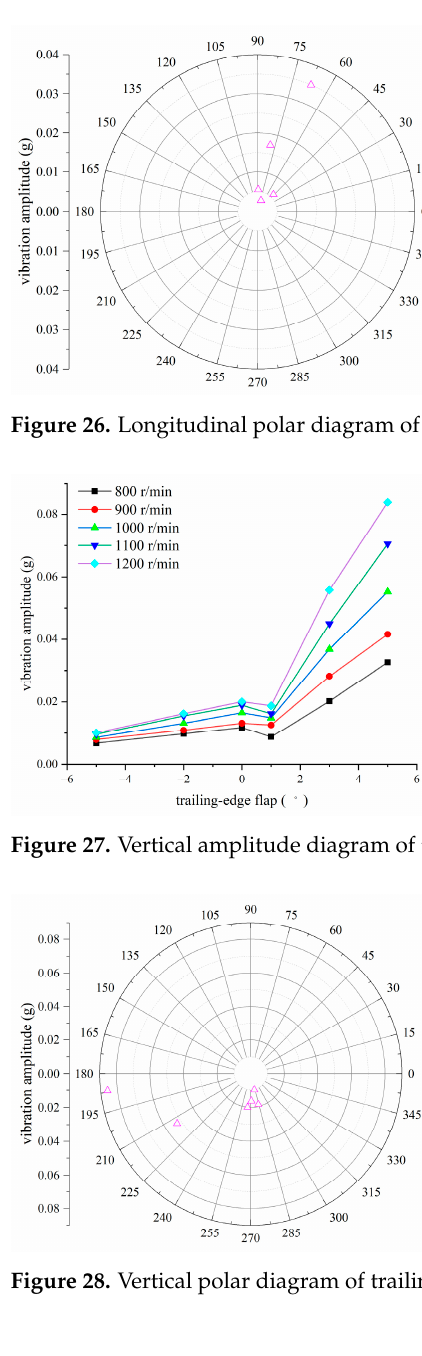
Figure 25. Longitudinal amplitude diagram of trailing-edge flap.